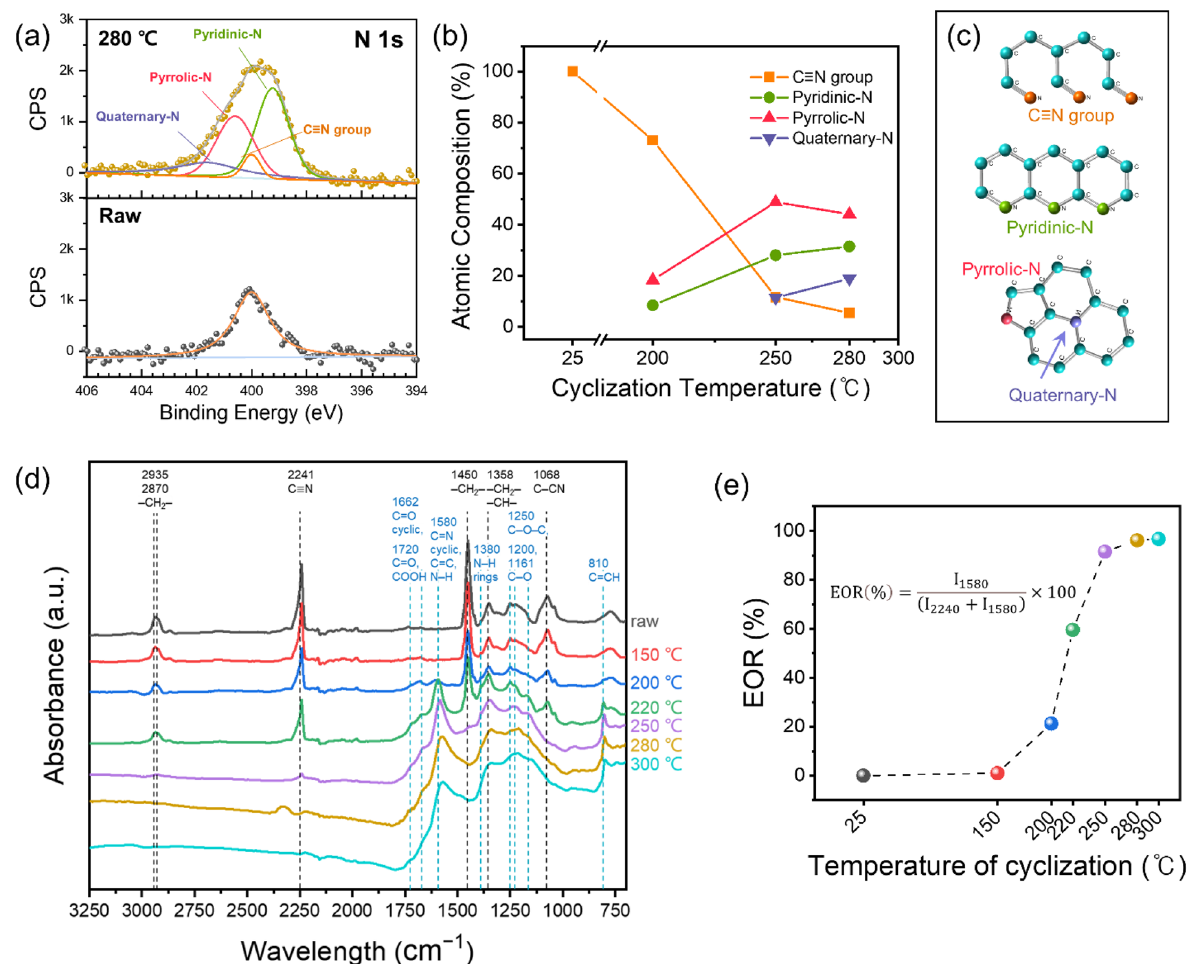
Fig. 2 Characterization of PAN‑containing CuO cathodes and PAN powder before and after cyclization at several temperatures. a N 1s X‑ray photoelectron spectroscopy (XPS) profiles of CuO cathodes with non‑cyclized PAN and 280 °C cyclized PAN, marked with “Raw” and “280 °C”, respectively. b Atomic composition of N‑containing functional groups at different cyclization temperatures according to their N 1s XPS profiles. c Structures of C N and pyridinic‑, pyrrolic‑, and quaternary‑N groups. d Fourier‑transform infrared (FTIR) spectra of the raw and cyclized PAN ≡ powder at temperatures in the range of 150–300 °C. e Extent of ratio (EOR) of the PAN cyclization reaction calculated using FTIR data